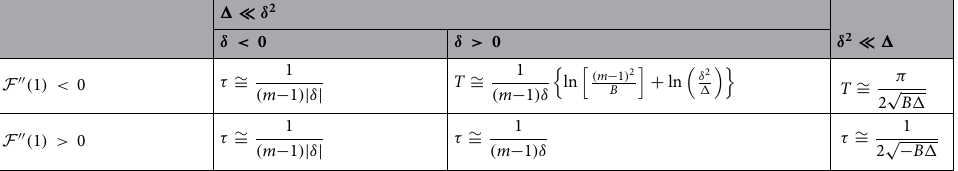
0 . Expressions for T represent total cascading time of Table 1. Asymptotics of collapse times for � , δ → unstable systems that suffer large-scale collapse, and expressions for τ represent the exponential relaxation rate of stable systems that suffer small-scale